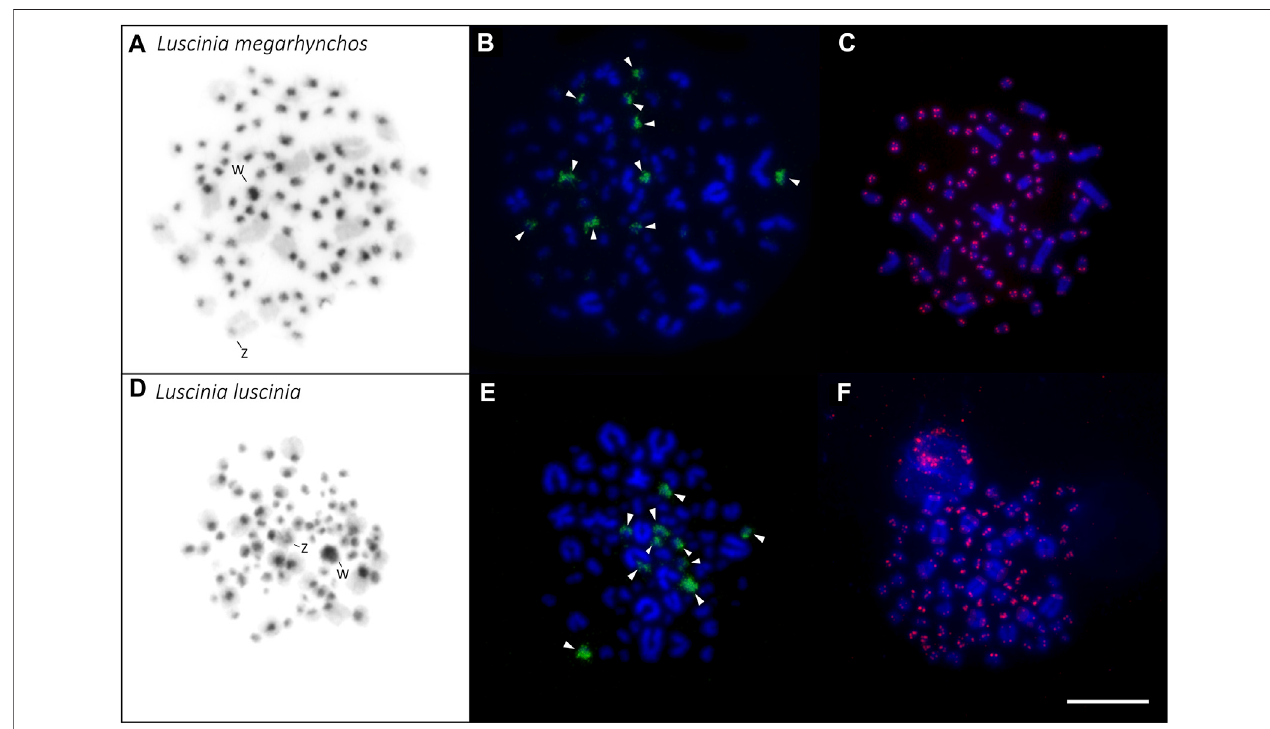
FIGURE4 | Distribution ofheterochromatin (A,D) , 18SrDNA clusters (B,E) and telomeric repeats (C,F) inthe karyotype of the twonightingalespecies.C-banding in the common nightingale ( L. megarhynchos ) (A) and the thrush nightingale ( L. luscinia ) (D) female karyotypes. Sex chromosomes are indicated in both karyotypes. rDNA clusters (green) in the common nightingale (B) and the thrush nightingale (E) . Arrowheads point to 10 microchromosomes displaying a rDNA signal. Telomeric repeat sequences (TTAGGG) n (red) in the common nightingale (C) and the thrush nightingale (F) . Scale bar (cid:1) 10